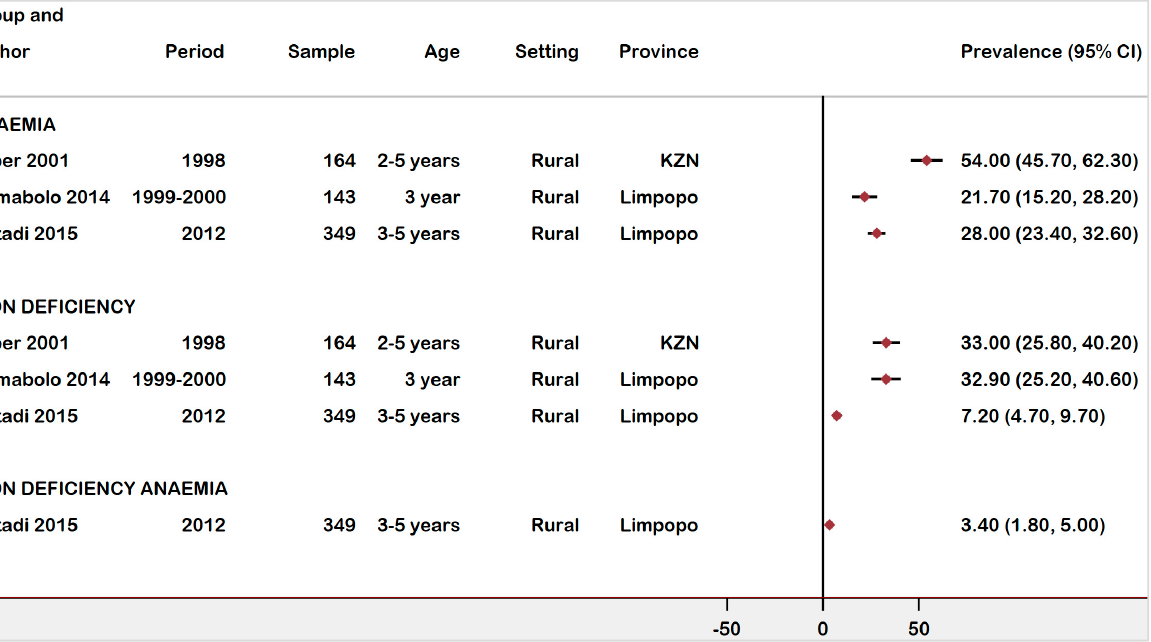
Figure 5. Forest plot of prevalence of anaemia, ID, and IDA in children age 24 months–59 months in South Africa, 1997-2021.